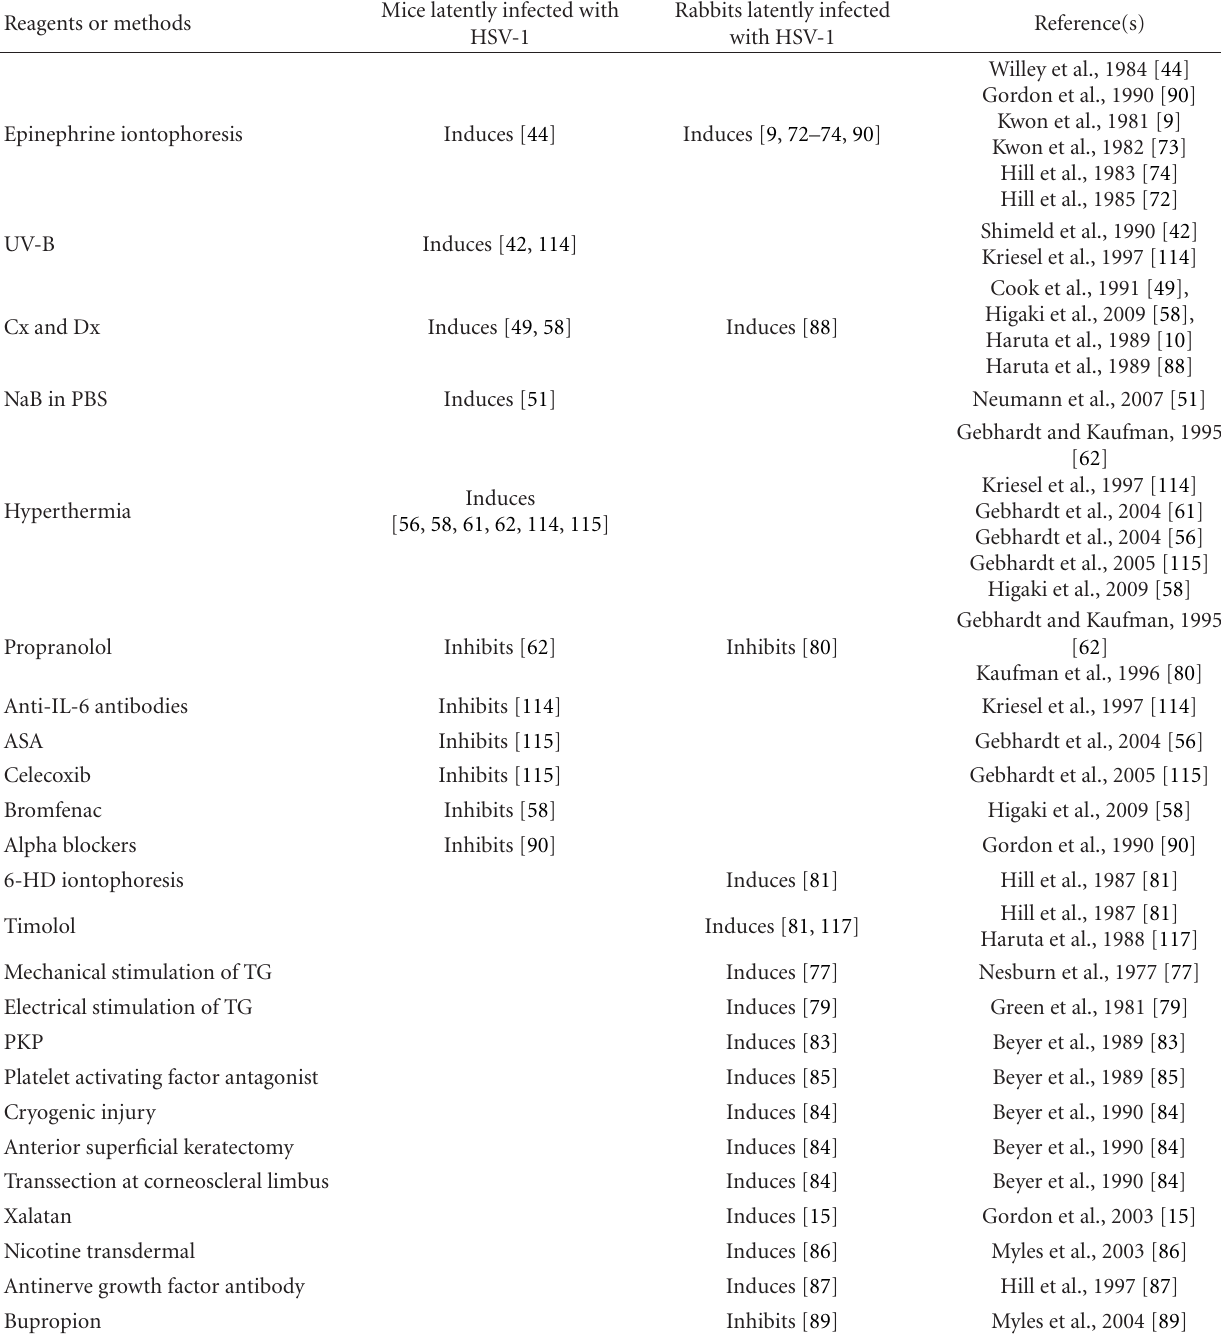
Table 9: Reagents or methods that can inhibit or induce HSV-1 reactivation for rabbits and